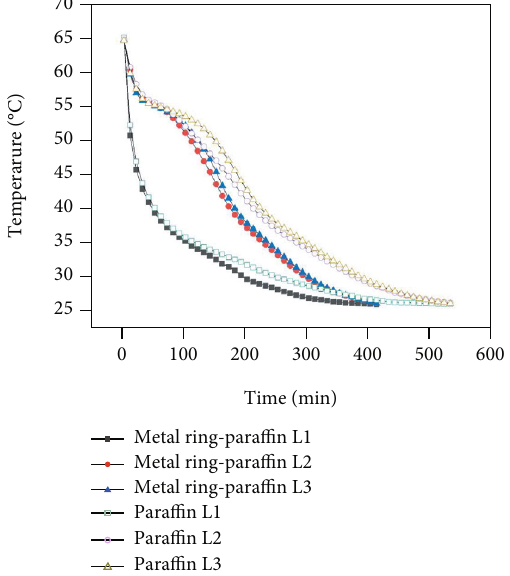
Figure 15: Temperature change of various fi ller materials for a heat storage device throughout the heat release